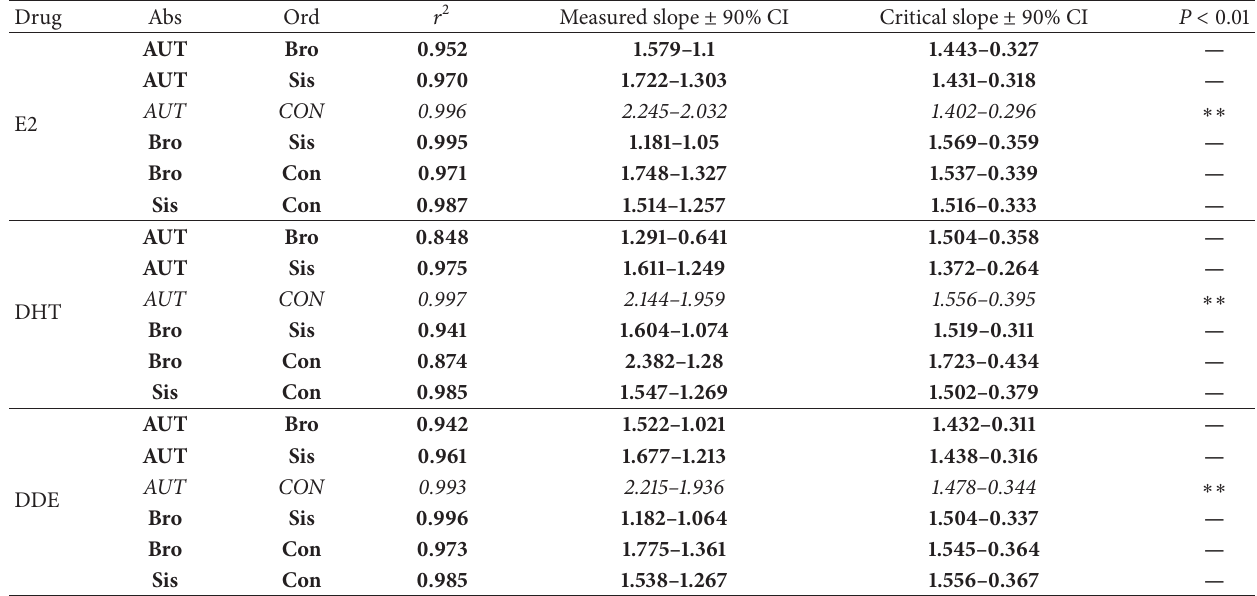
Table 3: Comparison of changes in XTT/LDH ratio.